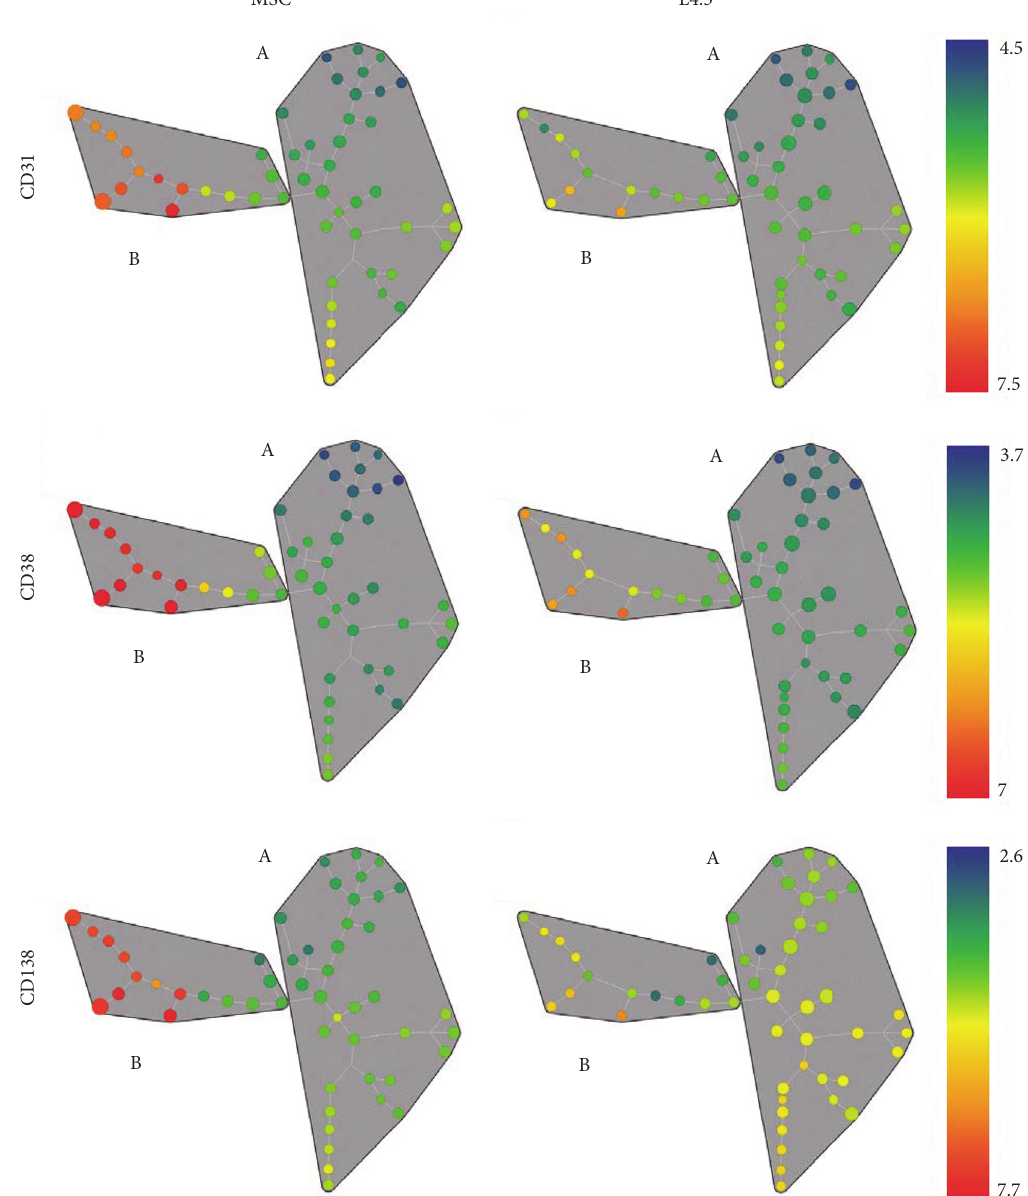
Figure 6: Two-dimensional analysis of differentiated A and B populations. CD31, CD38, and CD138 distributions in cells cultured with MSC and L4.5 cells were analysed on day 20 at the end of the differentiation phase. The strategy used to create SPADE trees was based on size and granularity as clustering channels with 50 nodes. Baseline was set with L4.5 in 21% O 2 conditions for each cell culture. Results shown are representative of 5 independent experiments. Mean fluorescence intensity ranging from low (green) to high (red) was used to localize CD31, CD38, and CD138 expression as indicated. Color scale was set to asymmetric to highlight differences between the